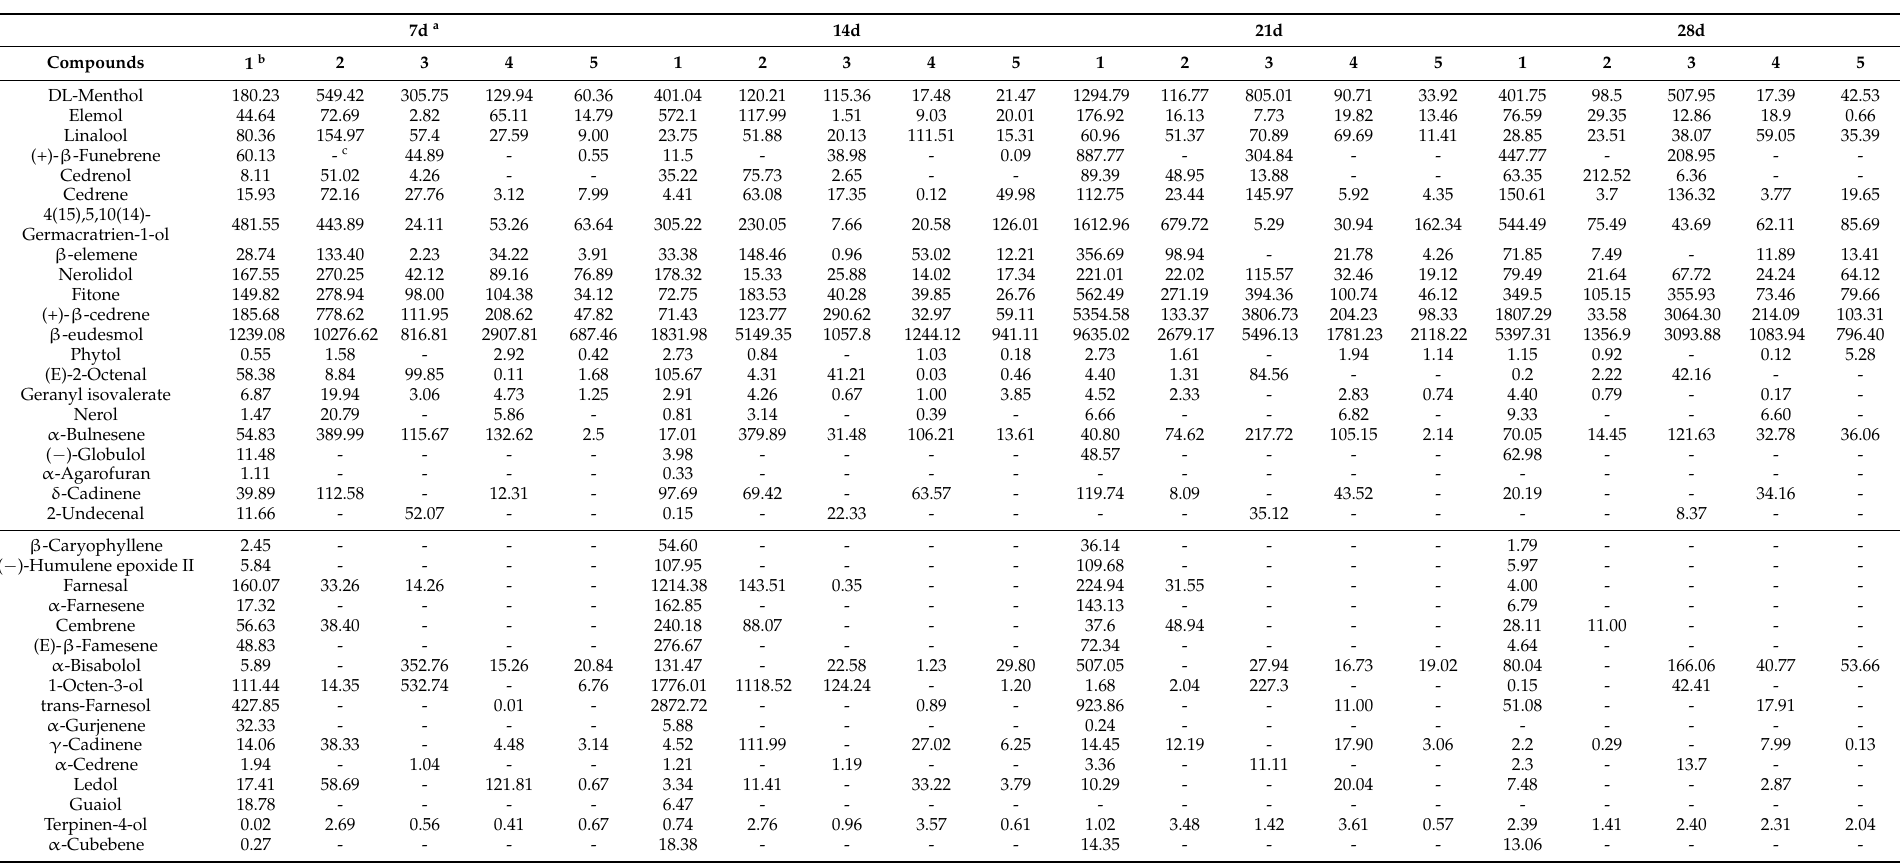
Table 3. Content ( µ g/kg) of terpenoids produced from different